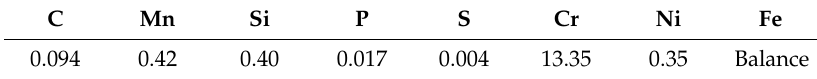
Table 1. Chemical composition of AISI 410 MSS (mass fraction,